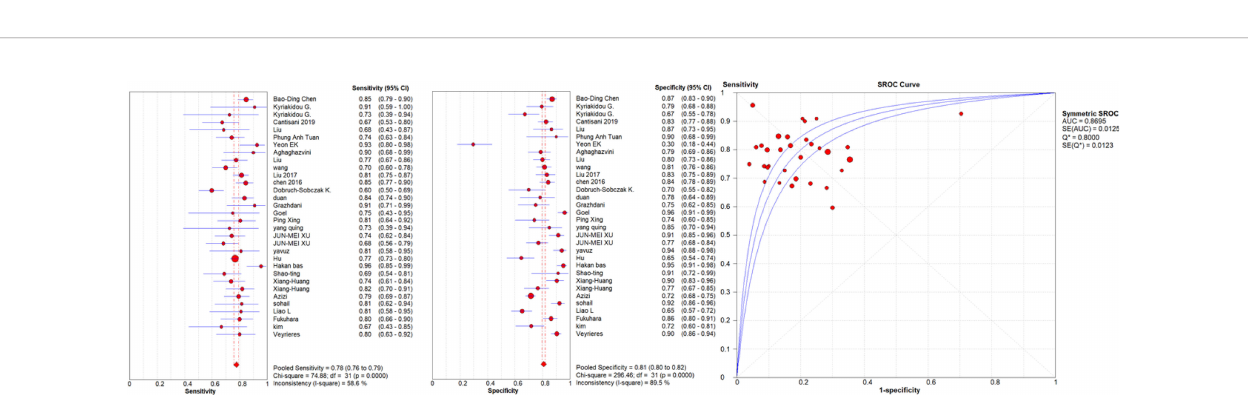
FIGURE 3 | Sensitivity and speci fi city forest plots and SROC curve for the quantitative USE. The circle size represents the nodule population of the selected articles; the line represents the con fi dence interval of the selected